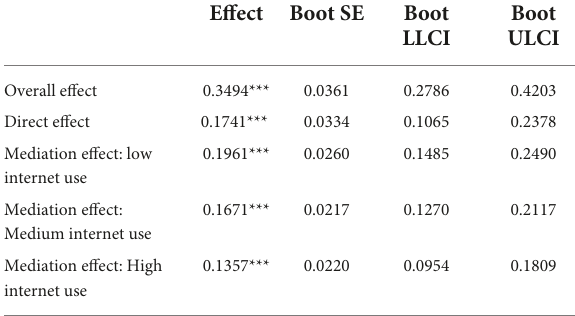
TABLE 5 Direct effects, indirect effects and overall